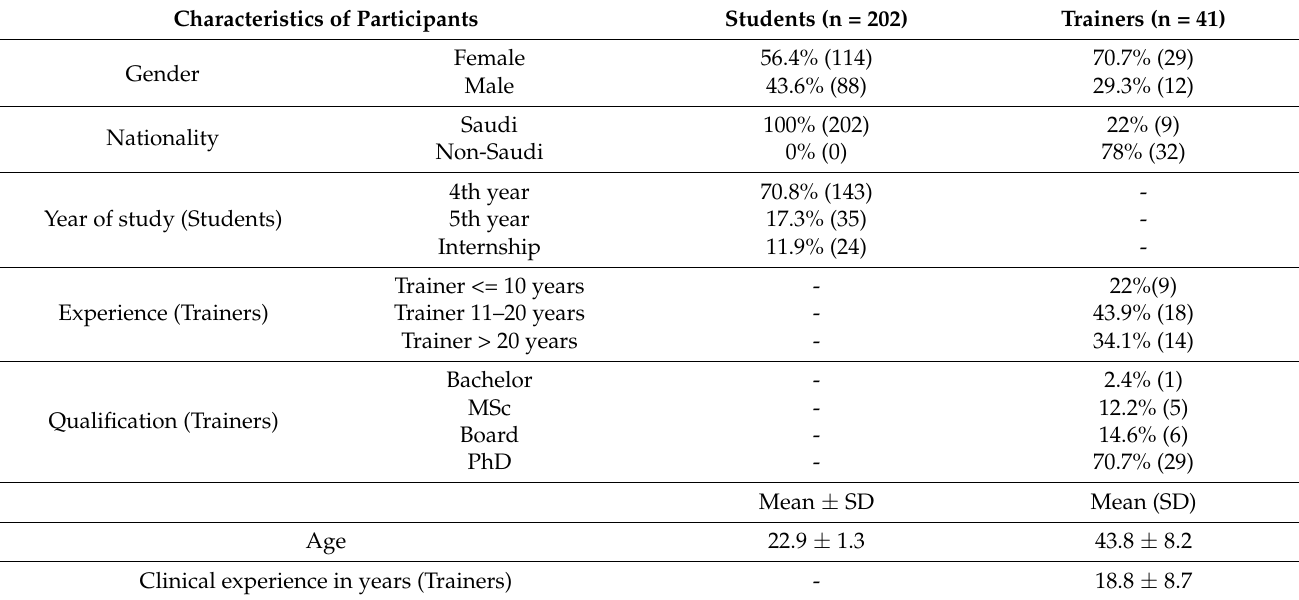
Table 2. Characteristics of